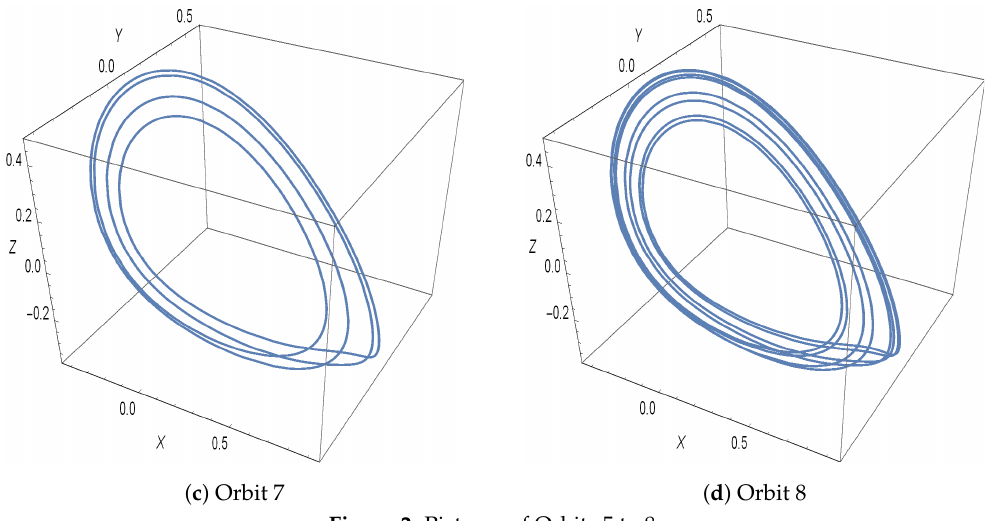
Figure 2. Pictures of Orbits 5 to